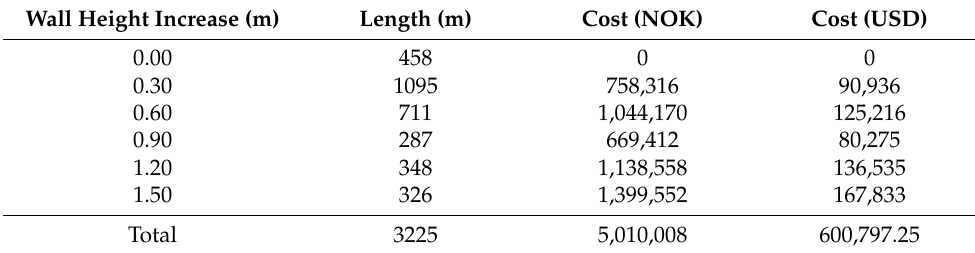
Table 3. Extra wall height needed, length, and